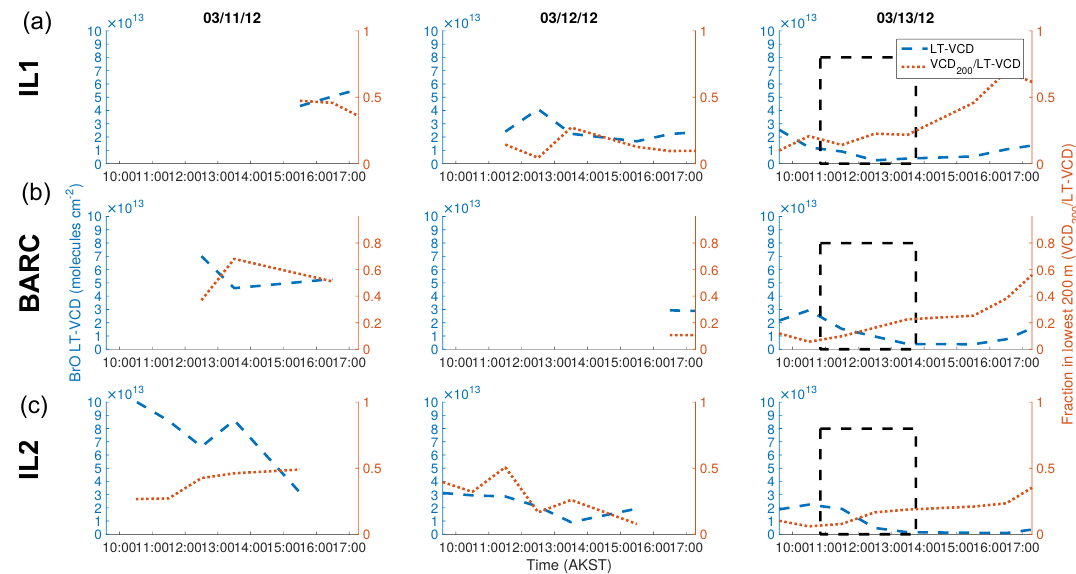
Figure 4. Summary of ground-based MAX-DOAS BrO observations near Barrow; all times are local. Observations are from IL1 (a) , the BARC building (b) , and IL2 (c) . The blue lines show the LT-VCD measured from the ground, and the red lines show the fraction in the lowest 200m. LT-VCDs are not shown when the degrees of freedom aloft is below 0.7, indicating reduced visibility.